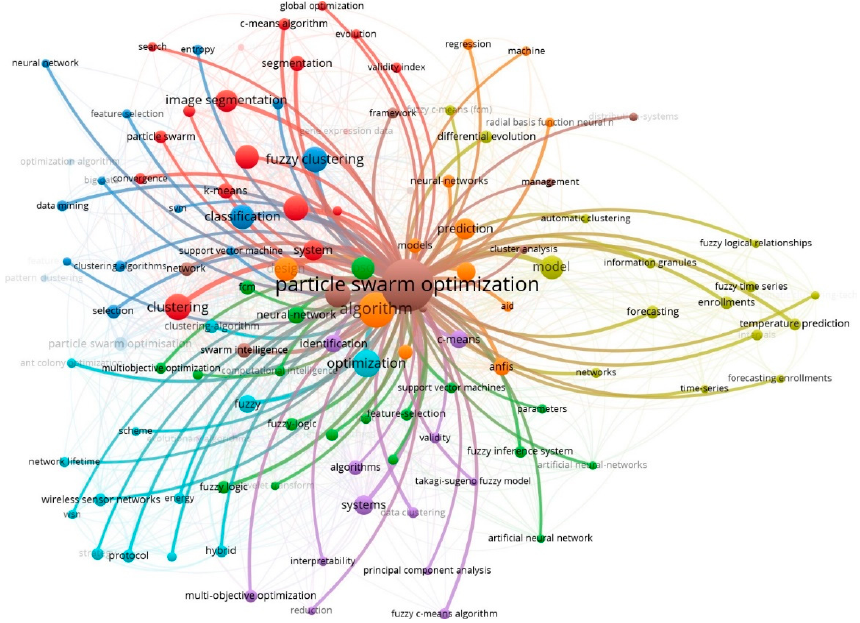
Figure 10. Representing the selection of the keyword “particle swarm optimization”.